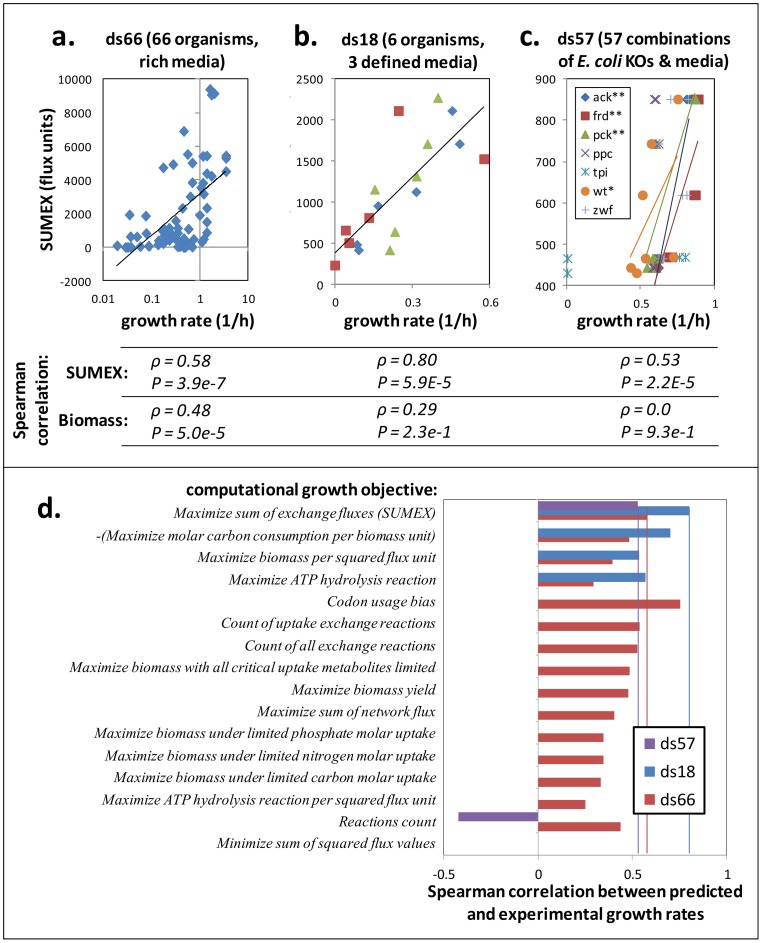
Correlation of different metrics to growth rate.(A–C) Spearman correlations of SUMEX vs. growth rate in three datasets. Colors in (B) represent media (green triangles, IMMxt; blue diamonds, IMM; red squares, IMM-gt; see Table S5 in File S1 for details). Colors in (C) represent strains. Trend-lines in (C) are shown for strains that individually show significance (*P≤5e-2, **P≤5e-3). Correlation values for SUMEX and Biomass vs. growth rate are listed below. (D) Significant (P-val ≤ 5e-2) Spearman correlations (i.e., ρ values) across three bacterial datasets for all tested metrics (non-significant correlations are not shown). Metrics are listed in descending order of the sum of ρ across the three datasets. Vertical lines denote rhos for SUMEX.